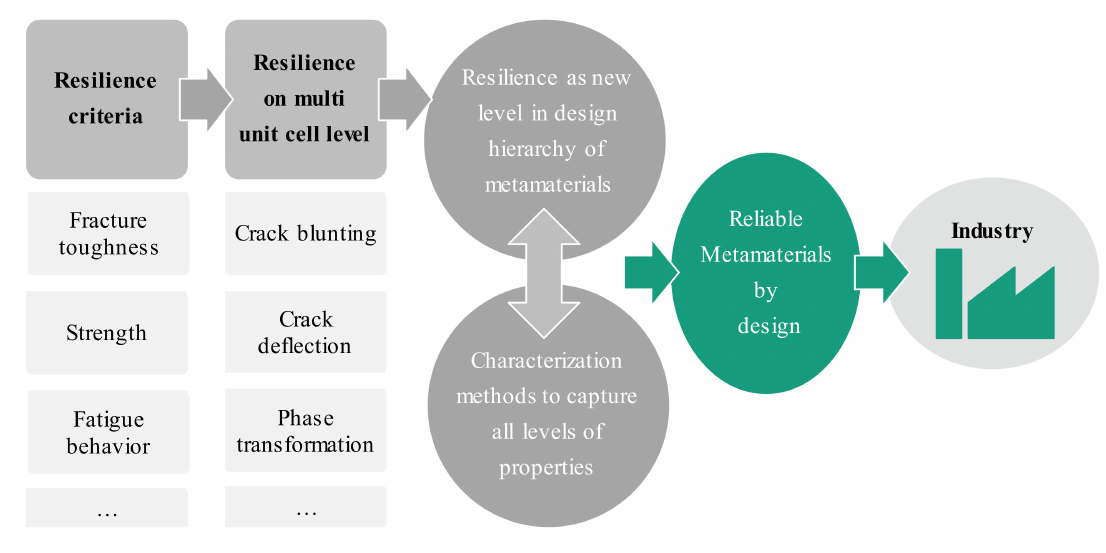
Figure 6. Key aspects to enable metamaterials for industrial applications: design for